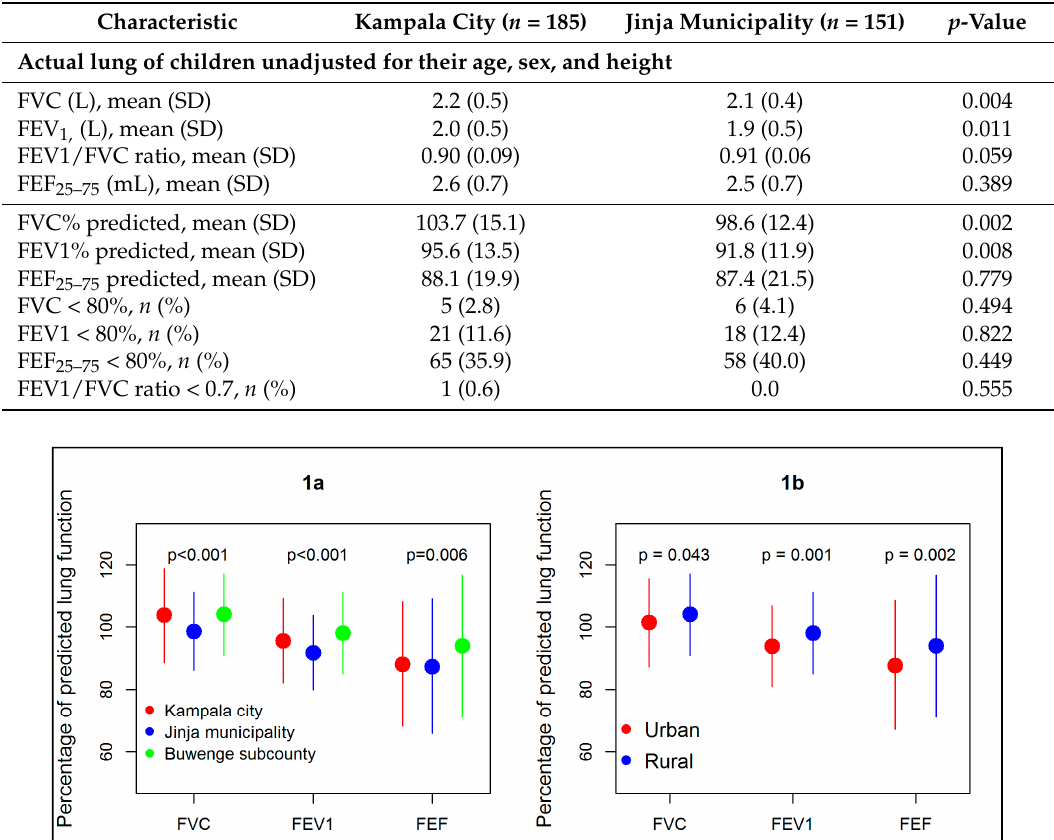
Table 5. Lung function of study participants comparing Kampala city and Jinja municipality. Characteristic